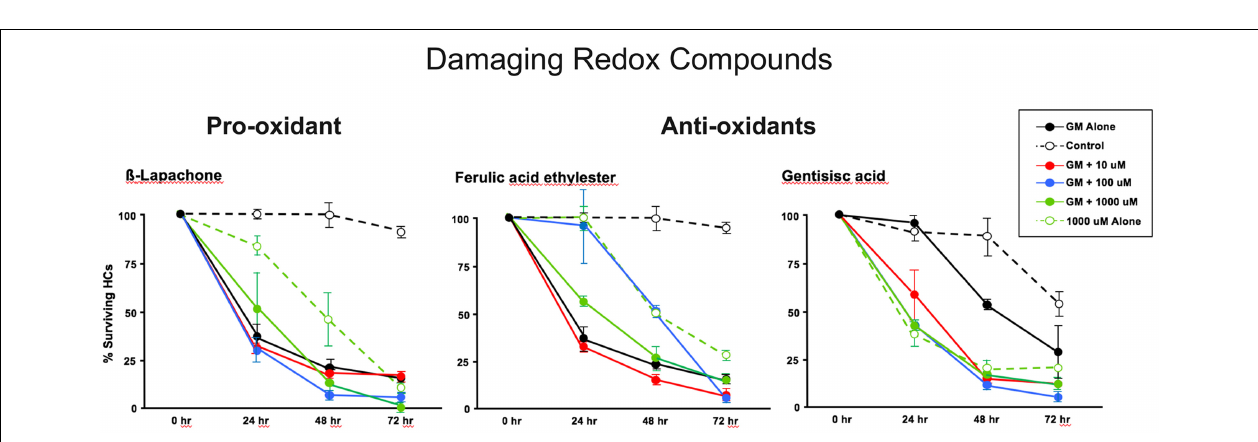
FIGURE 6 | Montages illustrating representative micro-explants treated with 100 µ M seratrodast plus 200 µ M gentamicin or 1000 µ M hinokitiol plus 200 µ M gentamicin, for 72 h.